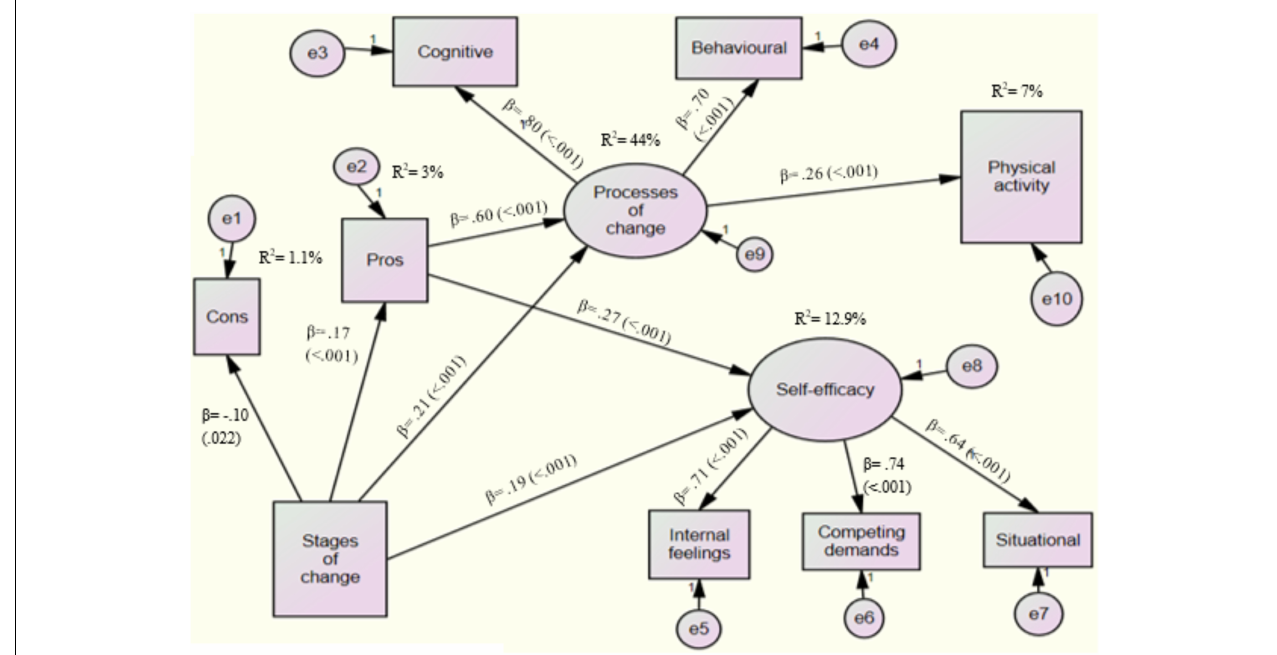
FIGURE 2 | Final structural model for explaining undergraduate students’ physical activity